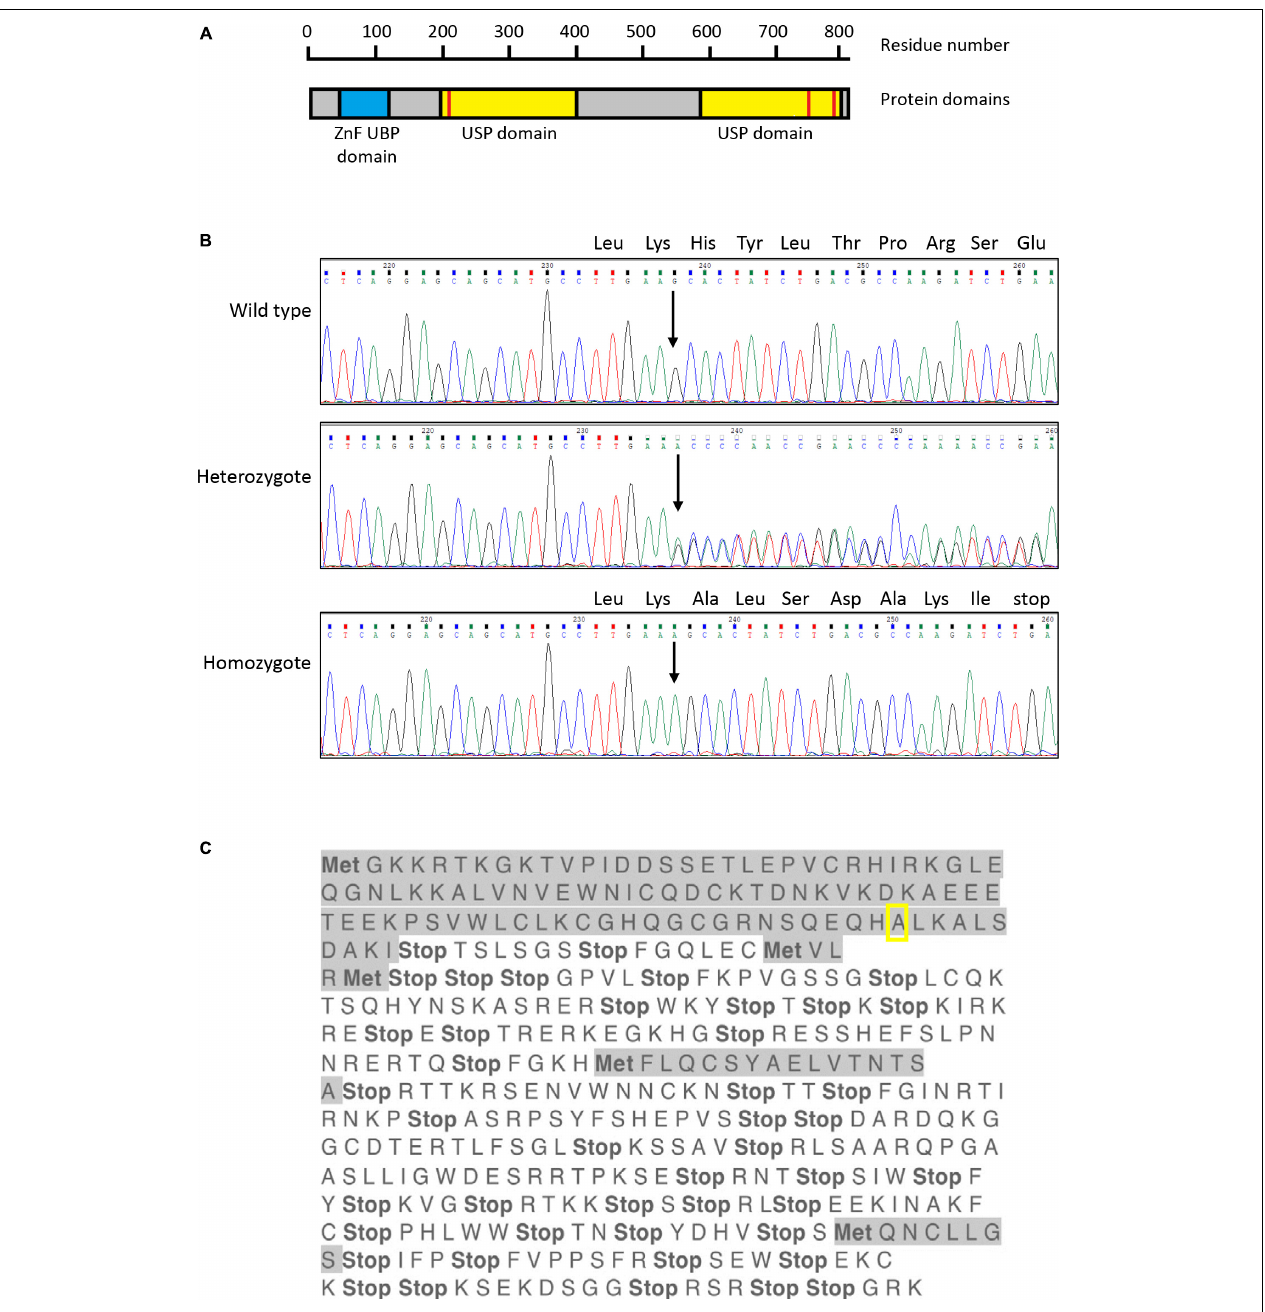
FIGURE 1 | Sanger sequencing of exon 4 of USP16 clones. (A) Structure of the human USP16 gene and protein. Blue – ZnF UBP domain; yellow – ubiquitin specific protease (USP) domains; red bars – cysteine (left) and histidine (right) boxes of the C19 family peptidase domain. Asparagine at position 200 and cysteine at position 205 are key residues of the cysteine box; histidine at position 758 and aspartate at position 798 are key residues of the histidine box. The peptidase unit extends from residue 141 to the C terminus at residue 823. The USP domains are members of the C19 family of cysteine peptidases. Drawn from data in Jones et al. (2013), Rawlings and Barrett (2013) and the MEROPS database at https://www.ebi.ac.uk/merops/index.shtml (Rawlings et al., 2018). (B) Sequence of USP16 in edited clones. Upper panel shows the wild type, middle panel shows a heterozygote and lower panel shows a homozygous edited clone. The site of the insertion is indicated by the arrow and the amino acid codons of the wild type allele are shown above the sequence traces. All three founder heterozygous clones had the same insertion of adenine (A; green trace) in one allele. The four homozygous USP16 − / − clones had the same insertion of one additional adenine, on both alleles. The nucleotide sequence before and after the insert was identical to wild type. ( C ) Translation of edited USP16 in homozygous clones by the ExPaSy tool (single letter code). Insertion of the single nucleotide causes a frame shift, which introduces multiple stop codons in the translated sequence. The insert is present in the middle of the zinc finger domain, in codon 91 for the amino acid alanine (pictured here framed by yellow box). Ten codons later, translation would be terminated by an in frame stop codon. Met indicates potential start codons (amino acid methionine), and highlighted sequences show open reading frames. The first gray sequence up to the yellow box is the correct amino acid